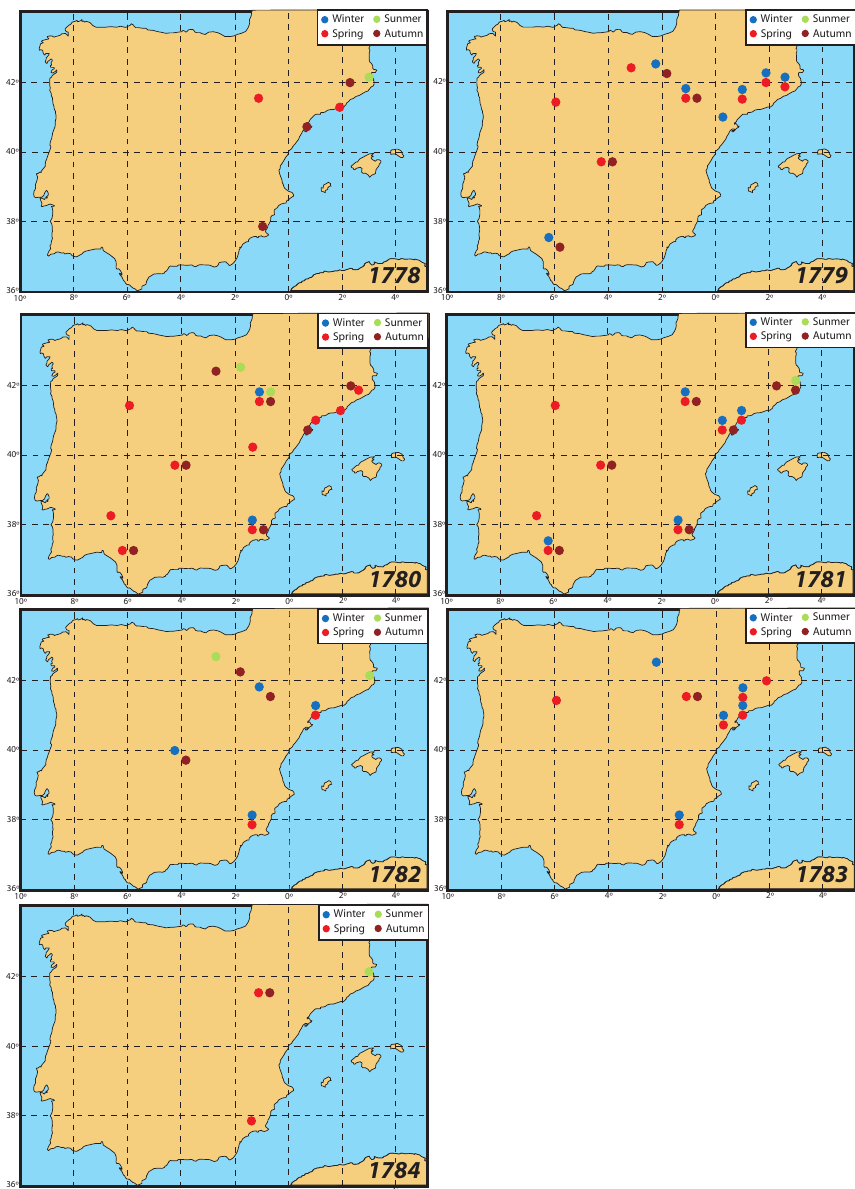
Fig. 5. Geographical distribution of rogations celebrated in Spain between 1778 and